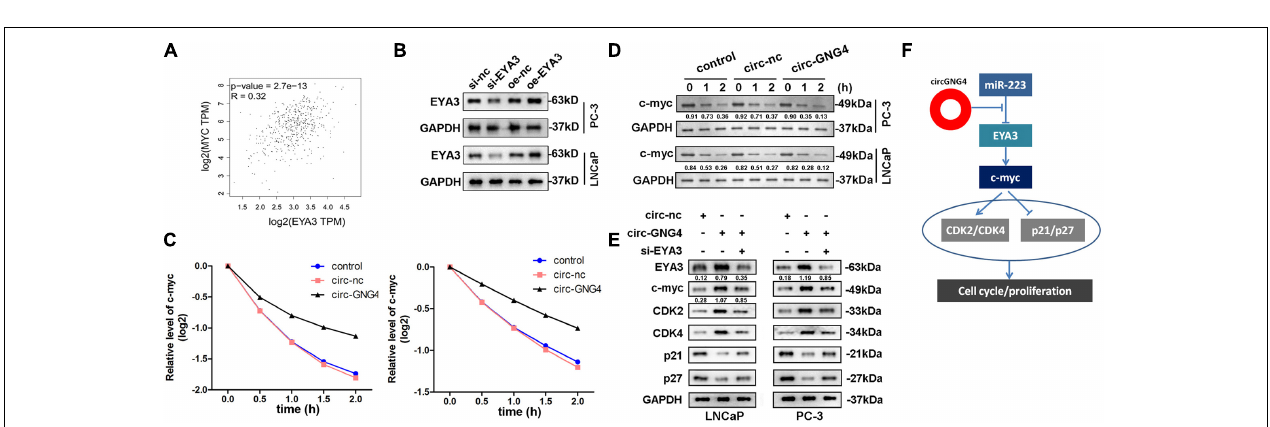
FIGURE 6 | CircGNG4 promotes tumor growth in vivo . (A) Gene Expression Profiling Interactive Analysis (http://gepia.cancer-pku.cn/) database was used to determine genes associated with EYA3. (B) Western blot was used to detect the expression of c-Myc after EYA3 knockdown or overexpression. (C) The half-life of c-Myc mRNA was detected by quantitative PCR. (D,E) Western blot detected the expression of EYA3, c-Myc and cyclin proteins. ** p < 0.01 vs. shNC group.